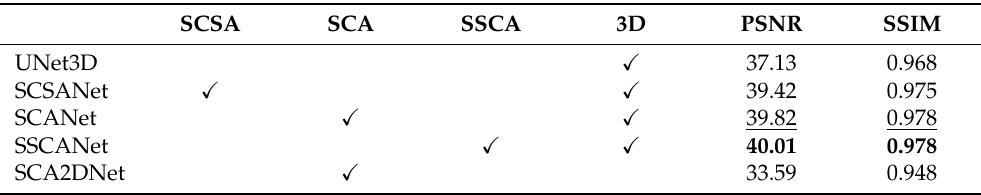
Table 2. Analysis of the impact of the suggested network architecture. Best and second best scores are highlighted and